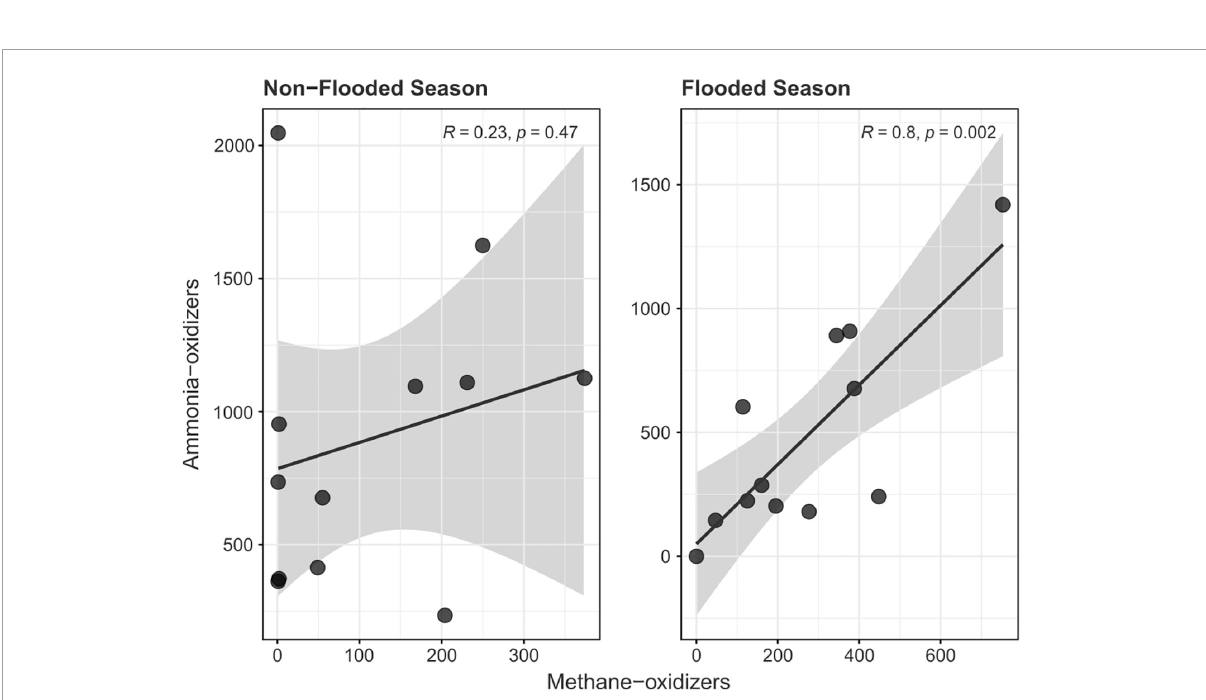
FIGURE4 Correlation between active ammonia-oxidizing and nitrogen-dependent anaerobic ammonia-oxidizing communities during the flood and non-flood